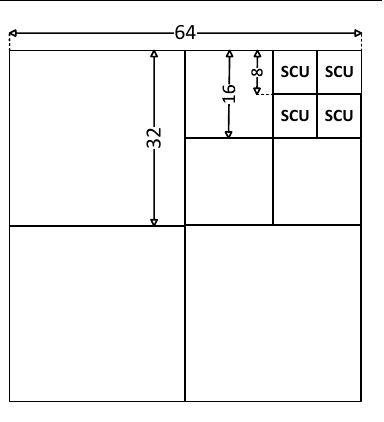
Figure 1. Demonstration of CU partitioning, where SCU is the smallest